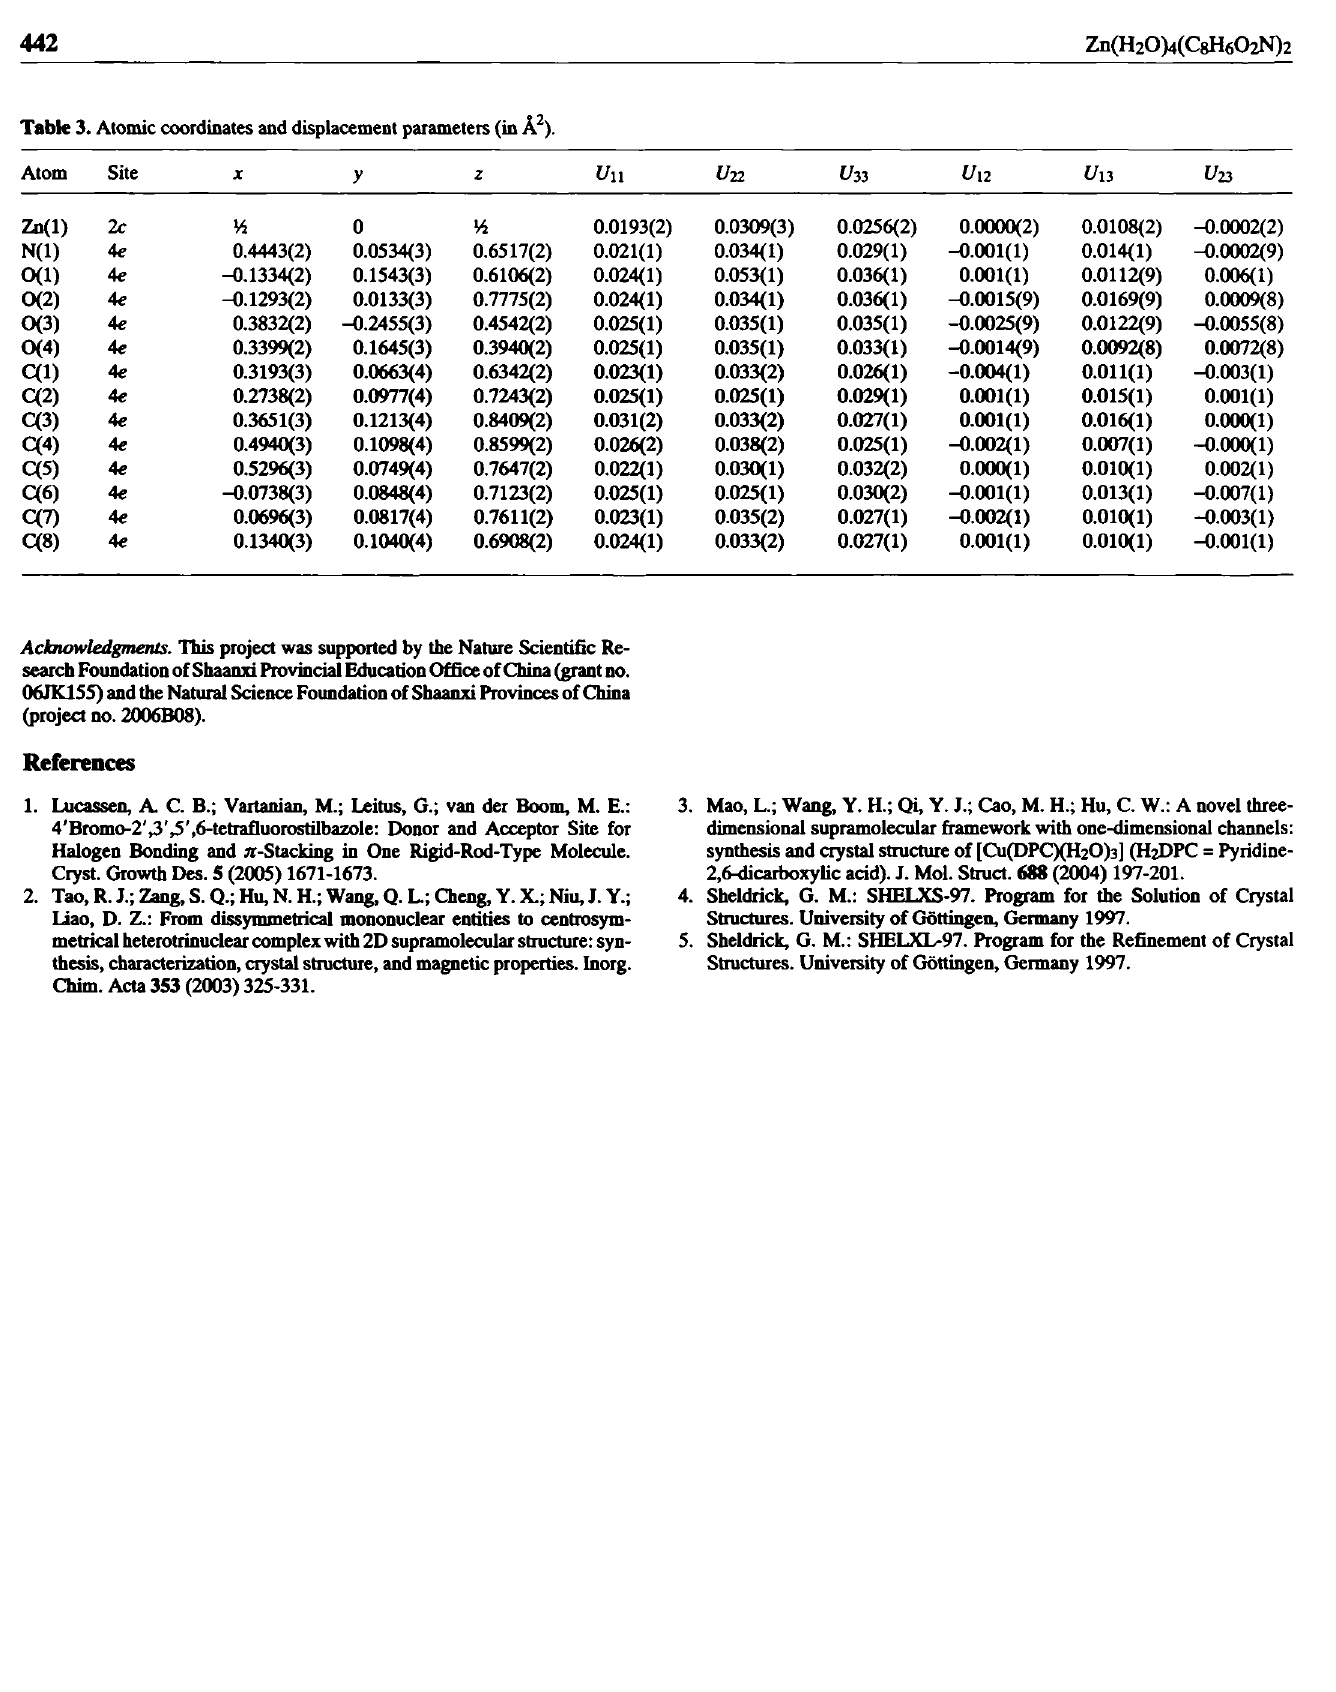
Table 3. Atomic coordinates and displacement parameters (in Ä 2